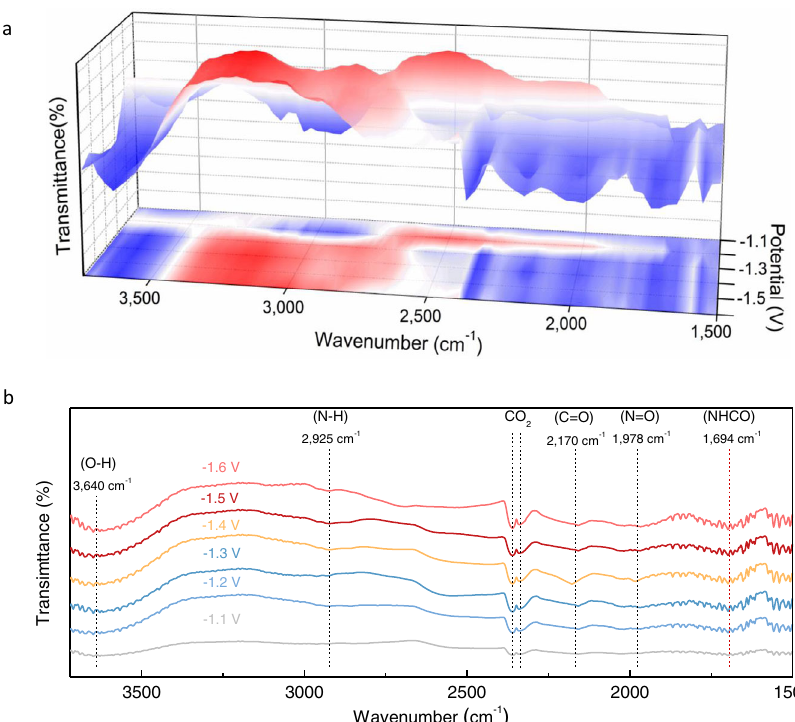
Fig.3|Operandoelectrochemicalspectroscopymeasurements.a Three-dimensionaloperandoSR-FTIRspectraintherangeof1500 – 3500cm − 1 . b Infraredsignalinthe range of 1500 – 3750cm − 1 under various potentials for B-FeNi-DASC during the electrocoupling of nitrate and CO 2